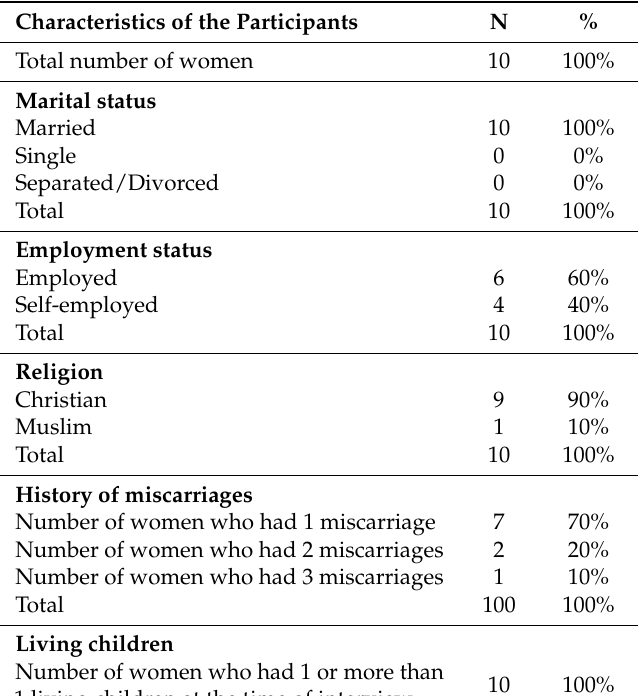
Table 1. Demographic characteristics of the study